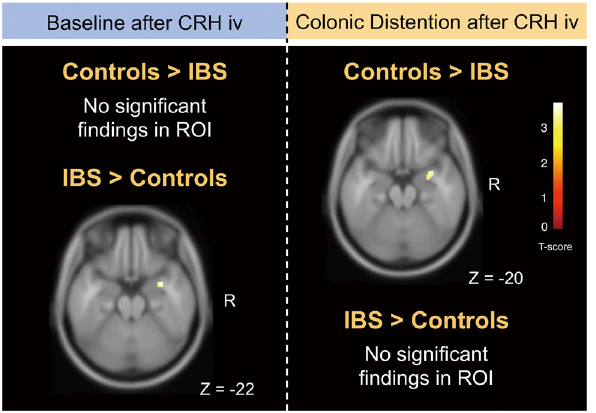
Fig 2. Regions showing significant activation changes. (Left) IBS patients showed significantly more activity than controls in the right amygdala at baseline after CRH injection compared with that at baseline before CRH injection. (Right) Controls showed significantly greater activation than IBS patients in the right amygdala at intense distention after CRH injection compared with saline injection than IBS patients. Results are shown rendered on a single-subject MRI template with axial sections using the threshold P FWE-corrected < 0.05 (voxel level, ROI analysis). doi:10.1371/journal.pone.0157347.g002 after CRH injection compared with saline injection between IBS patients and controls. Con- trols showed a significantly stronger response than IBS patients in the right amygdala during 40 mmHg distention after CRH injection compared with saline injection in ROI analysis (local = .020) (Fig 2). In the same maximum: x: 34, y: 4, z: -20; t = 3.78, cluster [k] = 34, ROI P FWE-corr contrast, none of the other ROIs were significantly more activated in IBS patients than in controls.